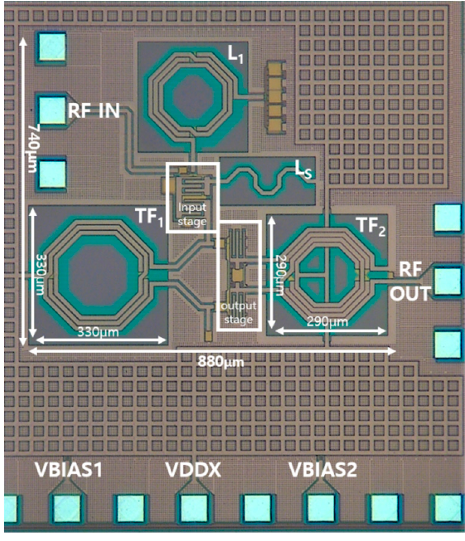
Figure 4. A microphotograph of the proposed PA. Electronics 2019 , 8 , x FOR PEER REVIEW